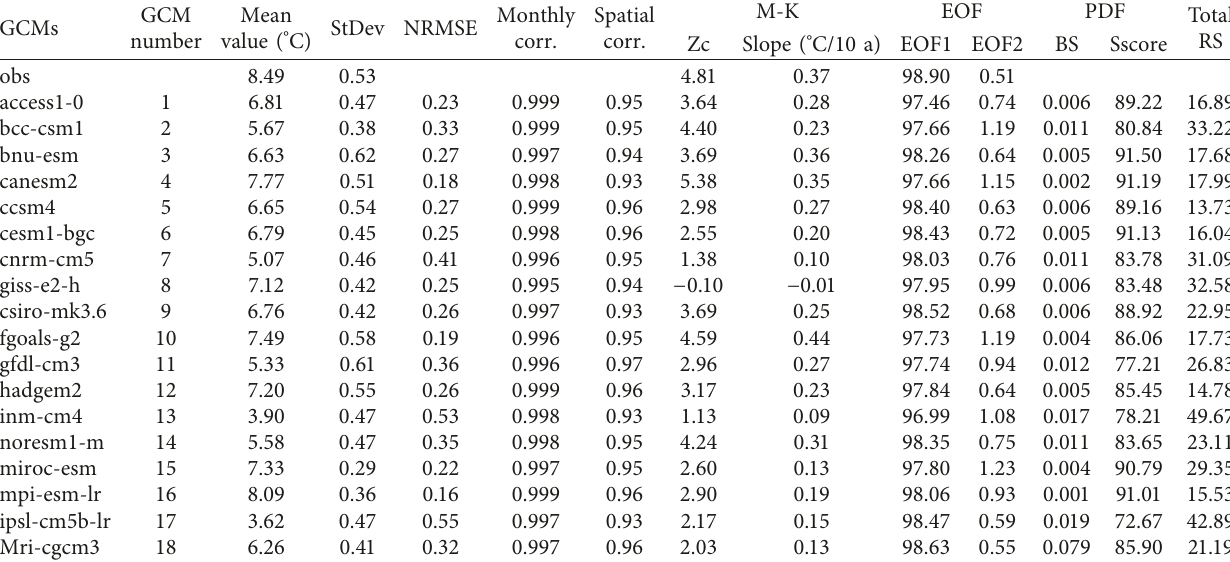
Table 2: Model performances for monthly mean temperature.